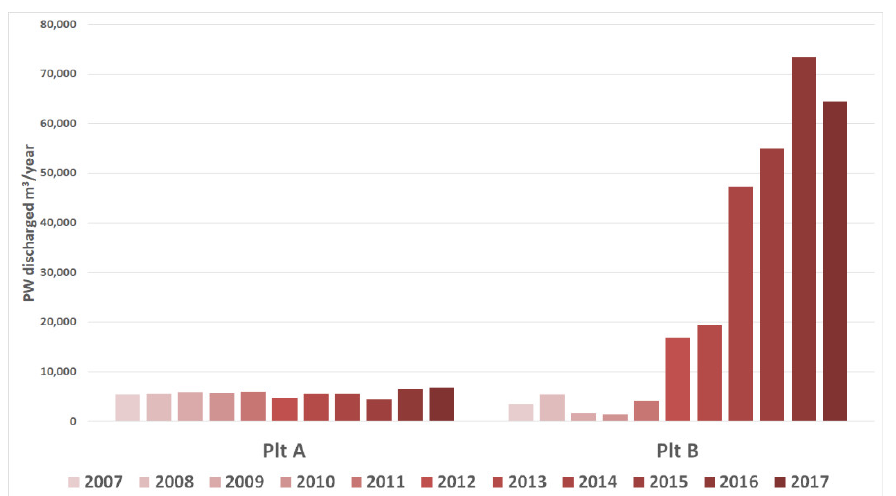
Figure 4. Produced water (PW) volume discharged in the period 2007–2017 from Plt A and B (data